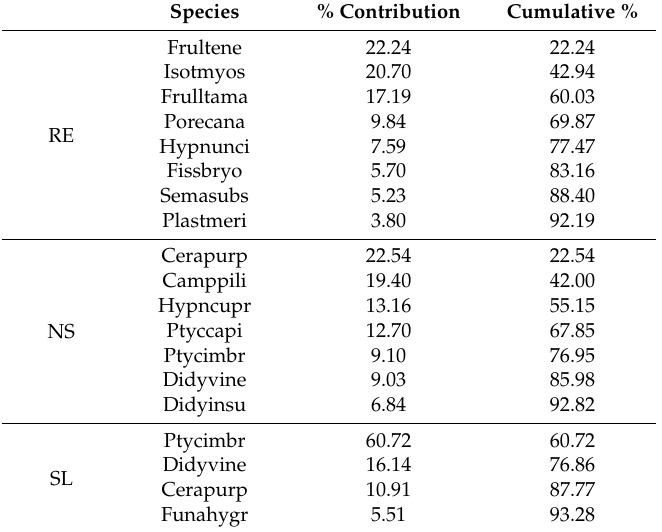
Table 3. Results of SIMPER (similarity percentage) analysis showing taxa that accounted the most to the similarities within plots of each transect.